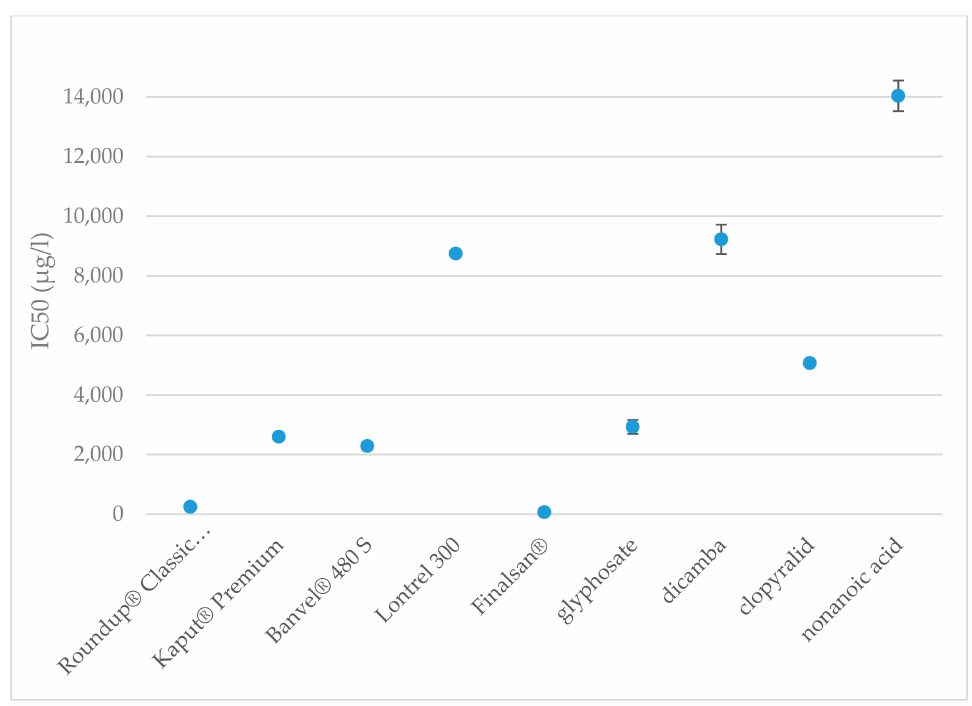
Figure 2. Toxicities of the herbicides and active substances after 30 min of exposure to A. fischeri . The data are expressed as the mean IC 50 value ± their respective standard